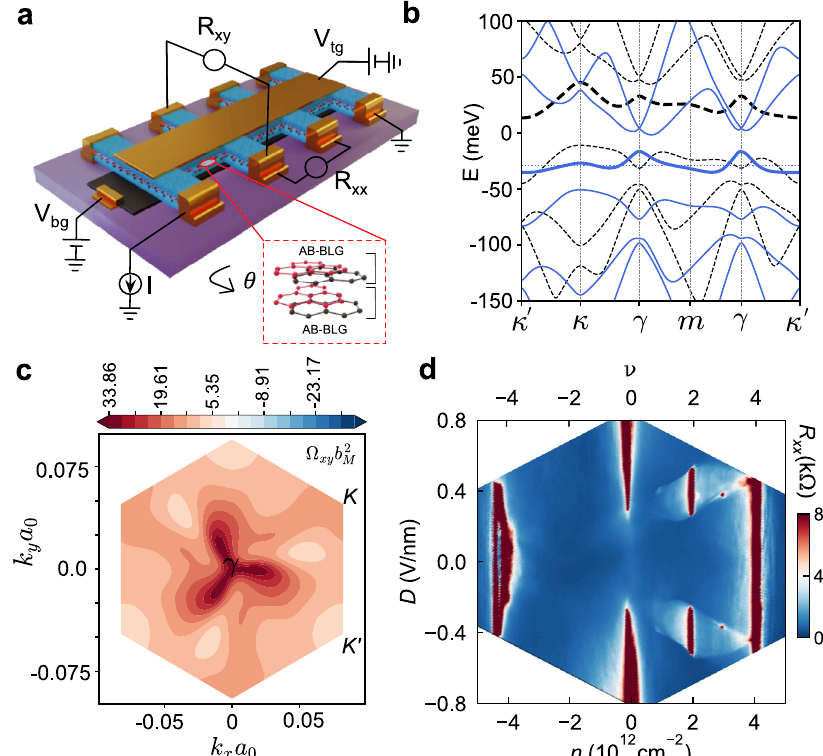
Fig.1|Twisteddoublebilayergraphene.a SchematicofatDBGdeviceconsistingof twoBernal(AB)bilayergraphenelayersstackedwithatwistangle θ ≈ 1.3°.Thestackis encapsulated with top and bottom hexagonal boron nitride ( h BN) layers, with a gra- phitebottom-gate( V bg )andametaltop-gate( V tg )toindependentlytunethedensity( n ) and displacement fi eld ( D ). b Calculated moiré band dispersion for tDBG with twist